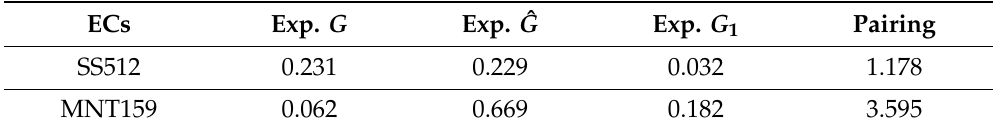
Table 1. Computation time (in ms) for the operation on the group and pairing over different elliptic curves on a laptop with the Intel Core i7-4785T CPU @ 1.70